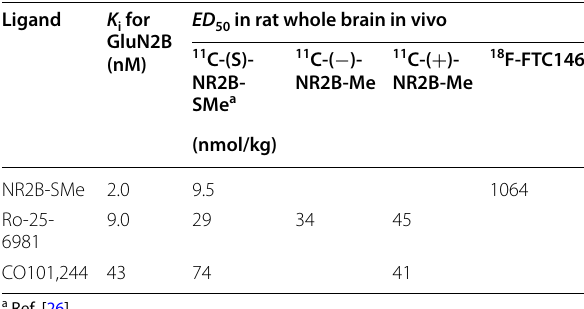
Fig. 4 Blocking of whole brain radioactivity uptake in rat by dosing with the GluN2B ligand Ro‑25‑6981 before intravenous injection of 11 C‑( )‑NR2B‑Me ( A ) or 11 C‑( )‑NR2B‑Me ( B ), and the respective fitted dose–response curves of Ro‑25 6981 from 11 C‑( − + 11 C‑( )‑NR2B‑Me, 11 C‑( S )‑NR2B‑SMe ( ED 50 34 nmol/kg, 45 nmol/kg, 29 nmol/kg) ( C ) and the respective fitted dose–response curves of Ro‑25 6981 + = from 18 F‑FTC146, 11 C‑( S )‑NR2B‑SMe ( ED